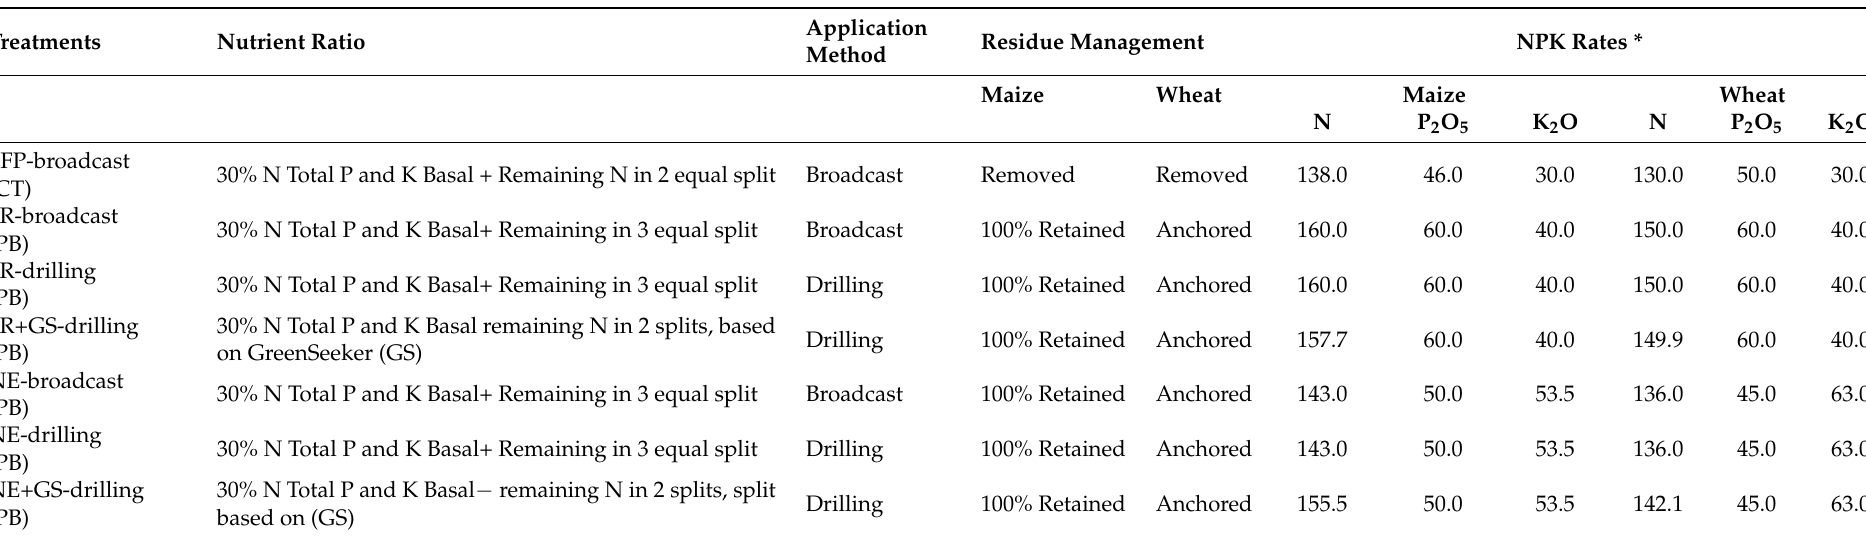
Table 2. Treatment description (tillage, residue, nutrient rate, application methods and management strategies) in maize-wheat system. Treatments Nutrient Ratio